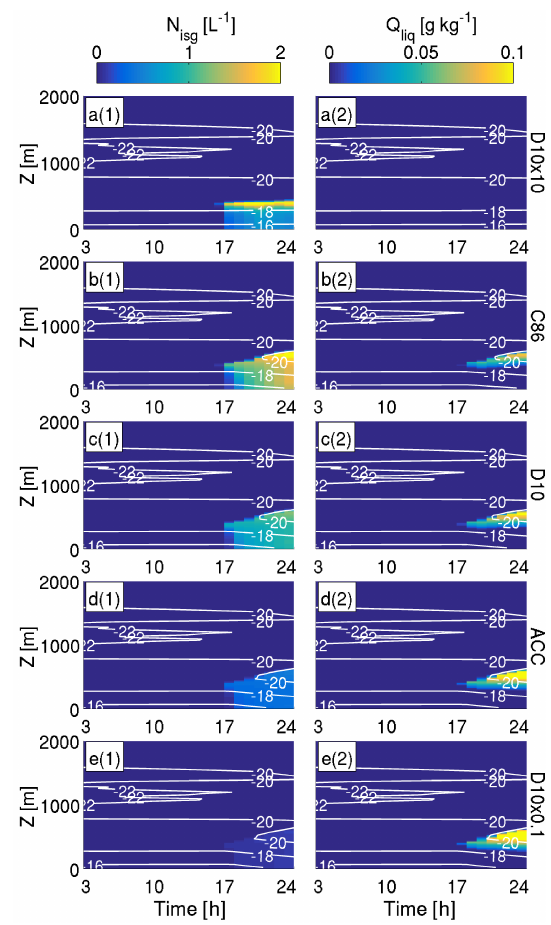
Figure 6. Simulated total ice number concentrations ( N isg , a1–e1 ) and liquid water mixing ratios ( Q liq , a2–e2 ) using the (a) D10 × 10, (b) C86, (c) D10, (d) ACC, and (e) D10 × 0.1 parameterisations for case 1 (sea ice). All are restricted to water saturation. Run length 24h. Temperature ( ◦ C) contours are overlaid in white. Runs are arranged such that the simulation which produced the most ice (D10 × 10, a ) is on the top row, and that which produced the least ice (D10 × 0.1, e ) is on the bottom row. Note the changing colour bar at the top of each column, which corresponds to data in that column